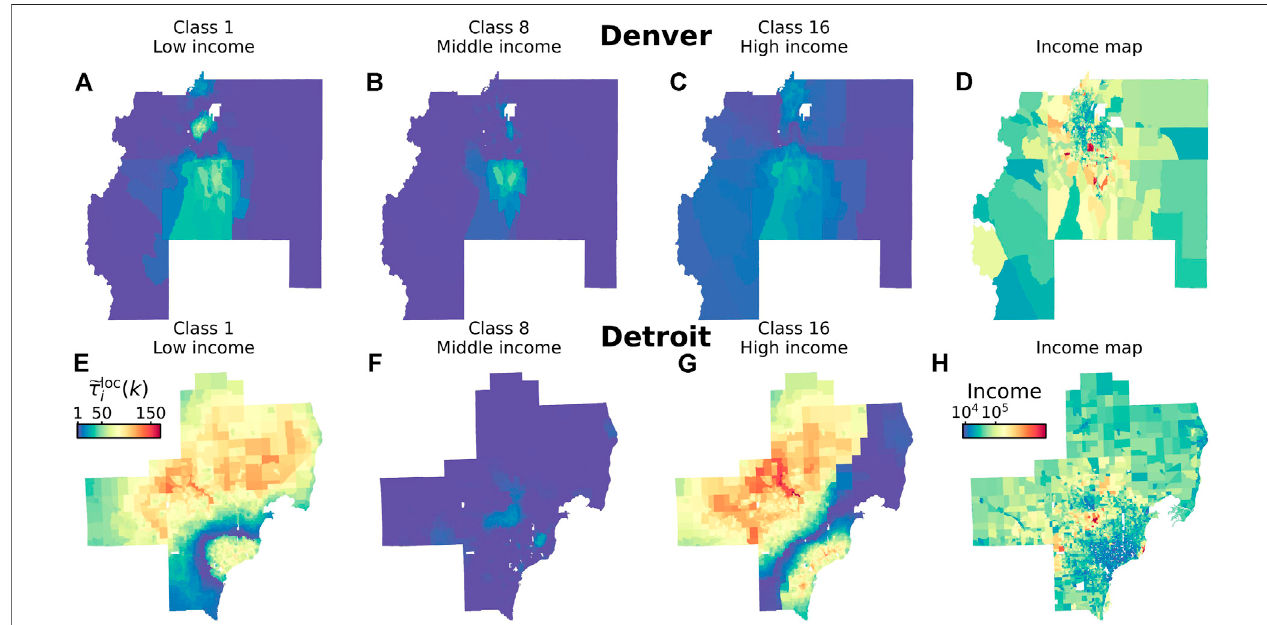
FIGURE 4 | Local synchronization time as a measure for income segregation. Normalized synchronization time for each census tract in Denver (A – C) and Detroit (E – G) forthreedifferentincomecategories: (A,E) class1(lowincome); (B,F) class8(middleincome); (C,G) class16(highincome).Weprovideasareferencethemedian income of each census tract in (D) Denver and (H)